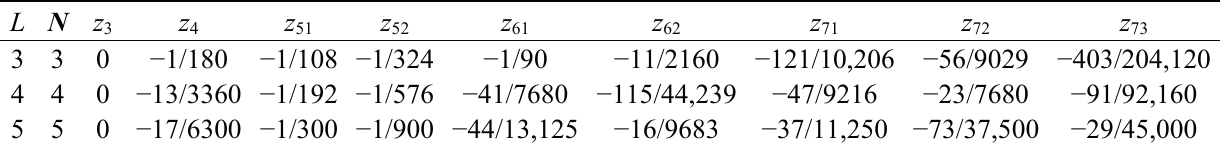
Table 13. Main attribution to maneuver error